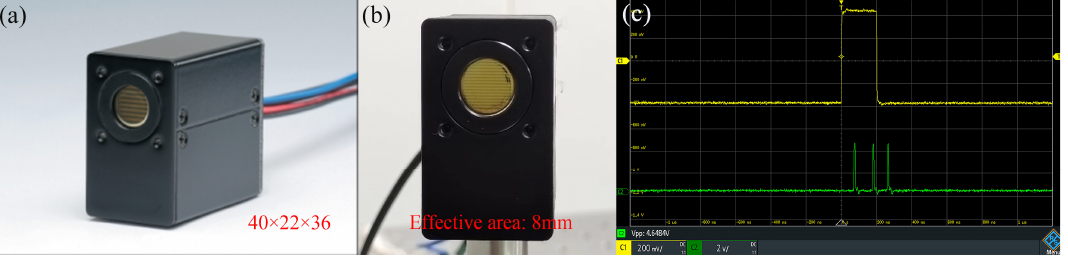
Figure 8. The appearance of the photon-counting module: ( a ) dimensions of the module, ( b ) the front view of the module, ( c ) the output waveform from the analog output of conventional photodetector (yellow curve) and PCM (green curve).